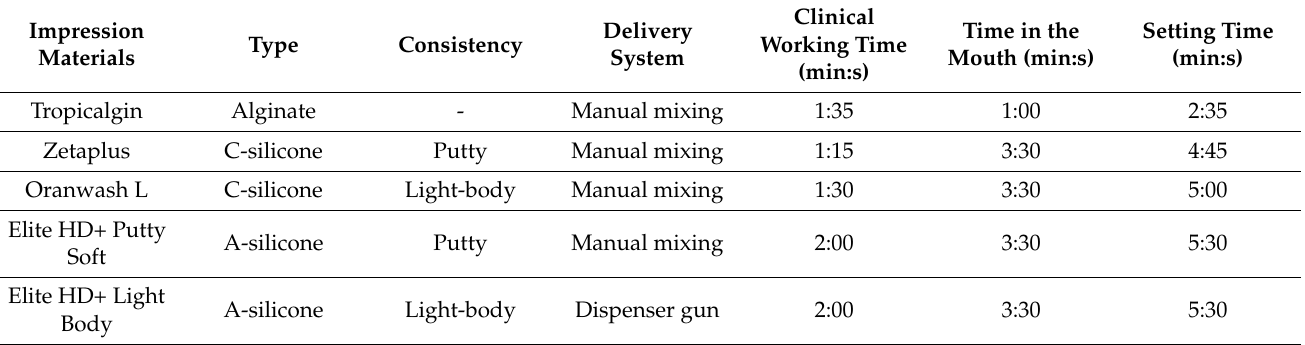
Table 1. The used-impression-material characteristics, according to the manufacturer (Zhermack ®